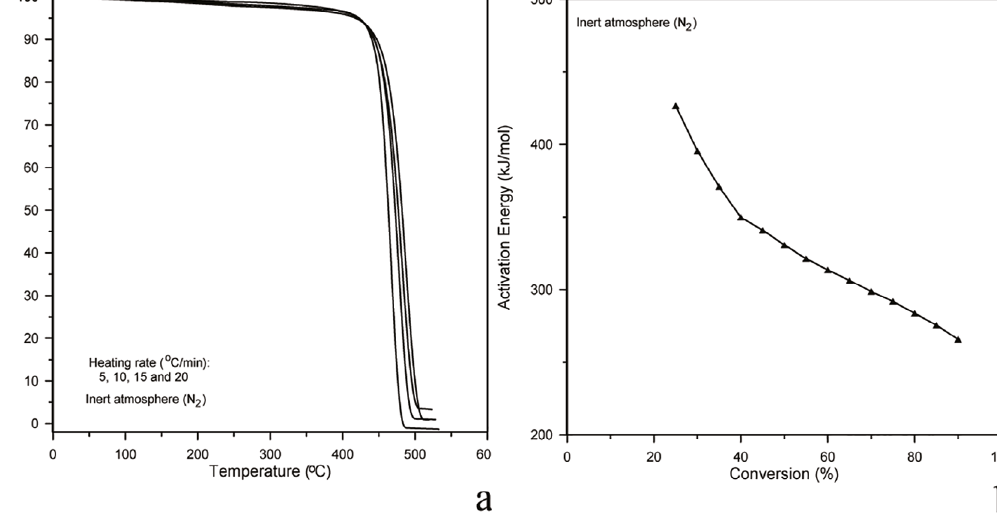
Figure 3. Thermal degradation kinetics on inert atmosphere of the laboratory (HDPE) high density polyethylene: a) Thermo gravimetric analysis for heating rate between 5 and 20ºC/min, b) Apparent activation energy obtained by isoconversional analysis of TGA